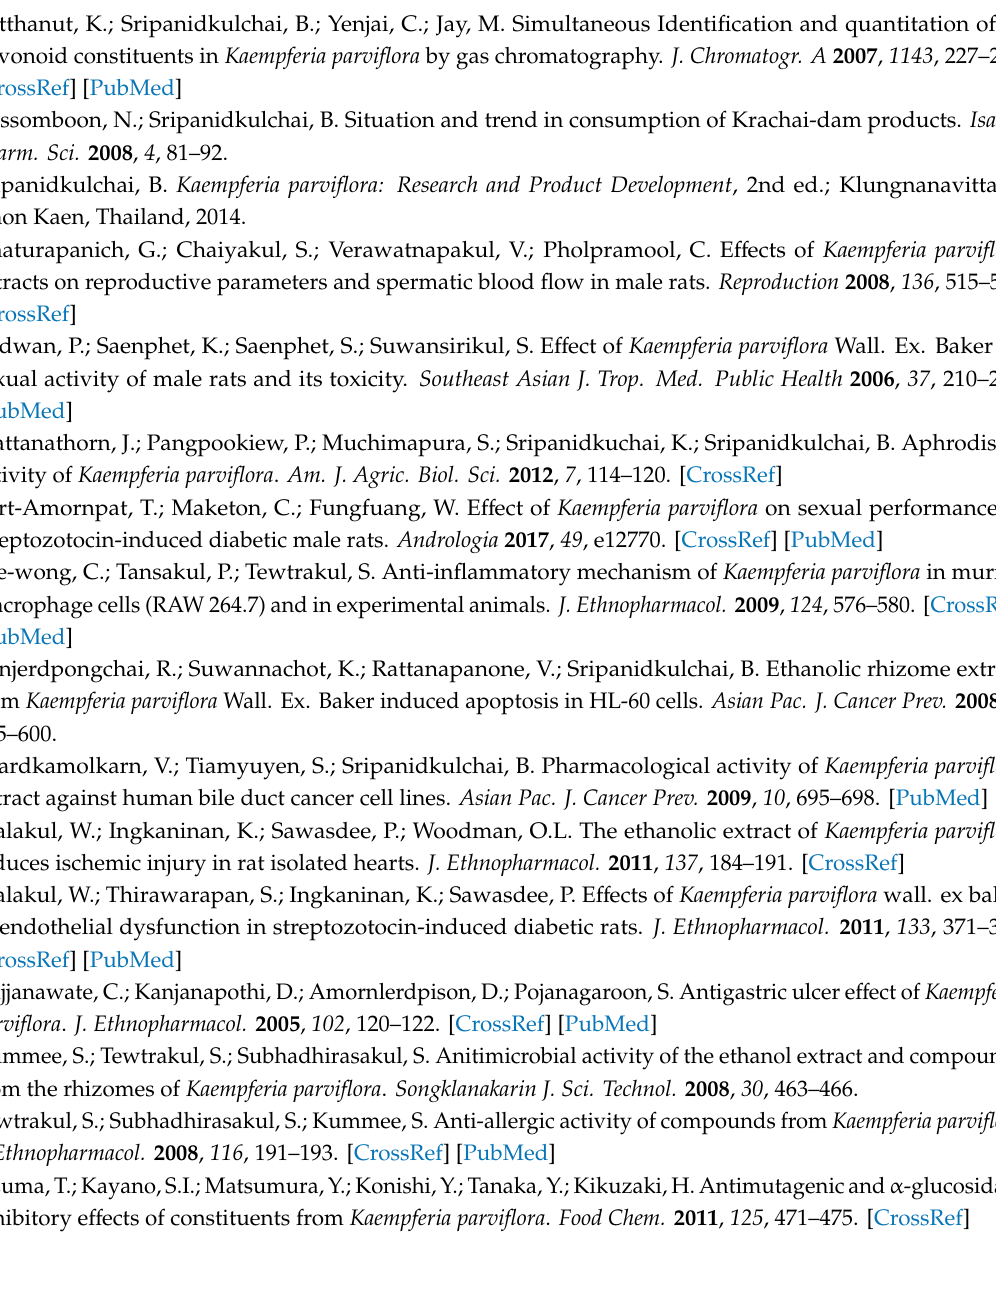
Table S1. General characteristics of participants. Table S2. Blood analysis of subjects at base line and at 28 days after KP treatment in glucose tolerance test. Table S3. Biochemical results of subjects at base line and at 28 days after KP treatment in glucose tolerance